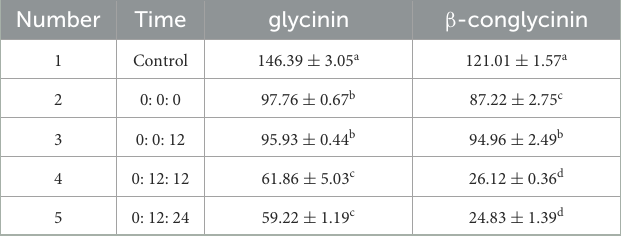
TABLE 2 Effect of timing of inoculation on glycinin and β -conglycinin contents ( n = 6).